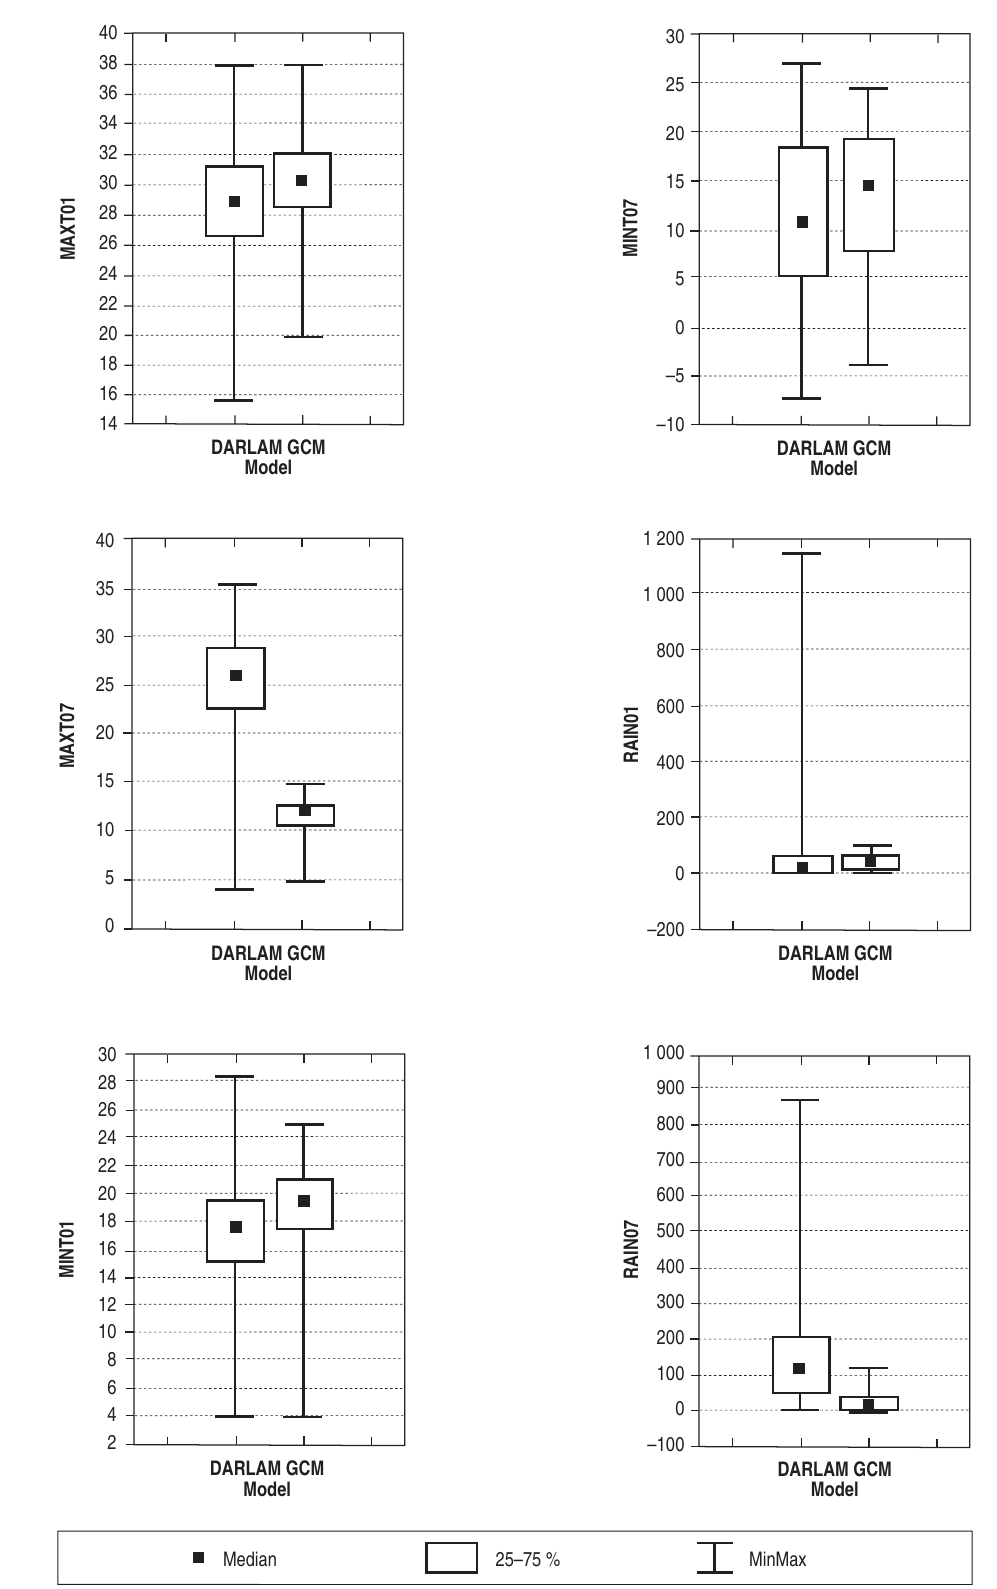
FIG. 9 Box plots based on the Kolmogorov-Smirnov test that compared climate predicted by DARLAM and a combined